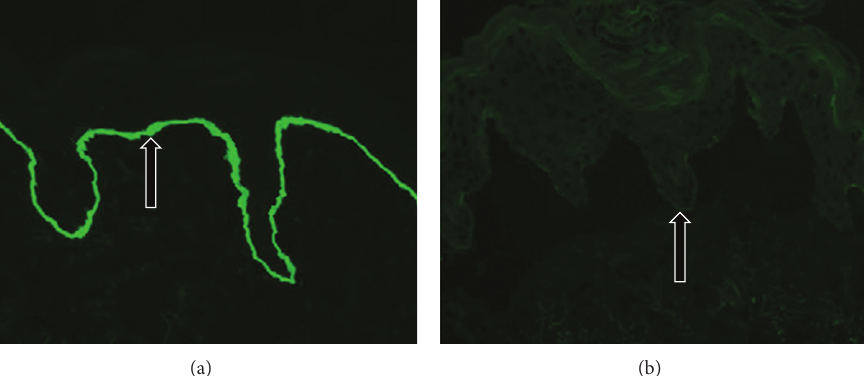
Figure 3: Immunofluorescence staining of the dermal-epidermal junction with antibodies to type VII collagen showing a control normal expression (a) and the minimal expression (b) of type VII